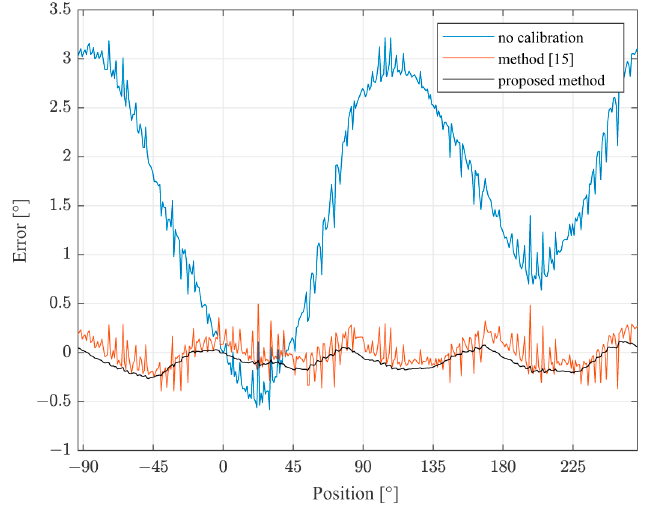
Figure 10. The deviation of the angle from the reference before and after the correction, with the uninclined sensor.